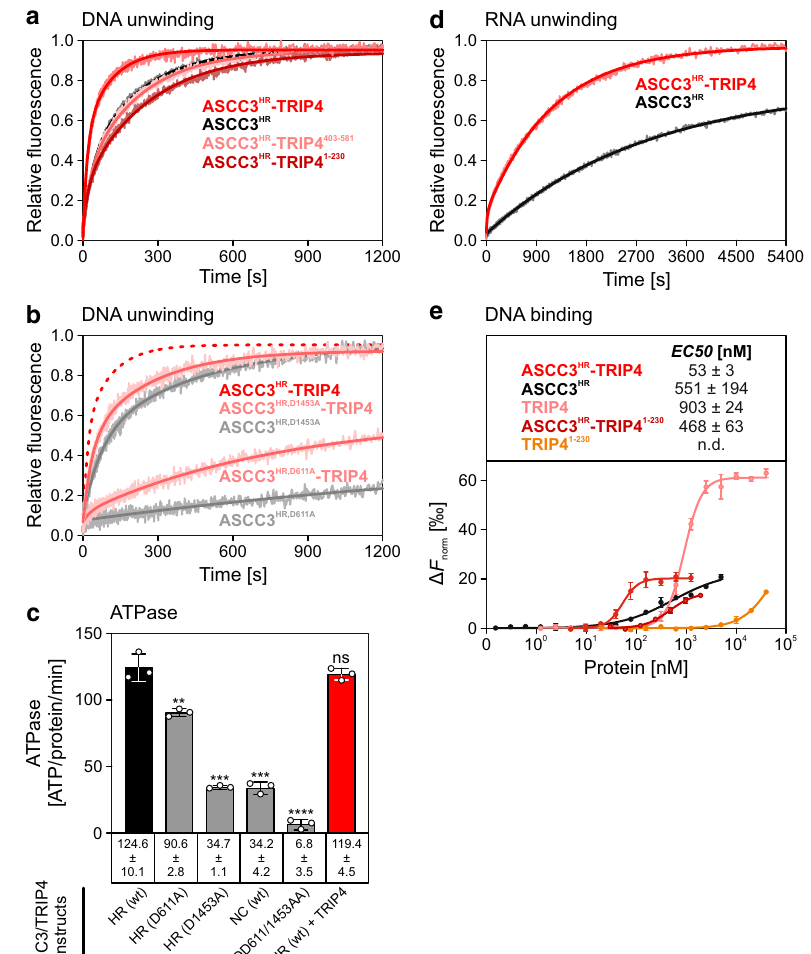
Fig. 3 | ModulationofASCC3 HR helicase, ATPase, and DNA binding activitiesby areshown.ApparentATPaserateswerecalculatedasdescribedin “ Methods ” andin TRIP4. a Stopped- fl ow/ fl uorescence-based DNA unwinding assays (no trap), Supplementary Fig. 7. Statistical signi fi cance was determined by unpaired, two- sided t tests. Signi fi cance indicators represent the signi fi cance of differences to wt showing that TRIP4, but not TRIP4 1 – 230 or TRIP4 403 – 581 , stimulates ASCC3 HR DNA ASCC3 HR ; ** P = 0.0049; *** P = 0.0001; **** P < 0.0001; ns not signi fi cant. ASCC3 HR helicase activity. In this and analogous experiments in the following, curves show fi ts of the data to a double exponential equation (fraction unwound = A – constructs,inwhicheithertheNC(D611A)ortheCC(D1463A)areinactivated,show fast *(1 exp( – k fast * t )) + A slow * (1 – exp( – k slow * t )); A fast/slow , unwinding amplitudes of the reduced ATPase activities, and TRIP4 does not signi fi cantly enhance the ASCC3 HR ATPase. d Stopped- fl ow/ fl uorescence-based RNA unwinding assays (no trap), fast/slow phases; k fast/slow , unwinding rate constants of the fast/slow phases [s − 1 ]; t , time [s]) 35 . b Stopped- fl ow/ fl uorescence-based assays (no trap) monitoring DNA showing that ASCC3 HR can unwind RNA duplexes and that ASCC3 HR -based RNA unwinding by ASCC3 HR constructs, in which either the NC (D611A) or the CC unwinding is also modulated by TRIP4. e MST assays monitoring DNA binding by (D1463A) are inactivated, alone or in the presence of TRIP4, showing that both NC the indicated ASCC3 and TRIP4 variantsor complexes. Data represent means±SD; and CC exhibit helicase activities that are stimulated by TRIP4. Data for n =3 (ASCC3 HR ), n=7 (ASCC3 HR -TRIP4), n =6 (ASCC3 HR -TRIP4 1 – 230 ), n =4 (TRIP4) or ASCC3 HR,D611A -based DNA unwinding had been reported previously 10 and are n =6 (TRIP4 1 – 230 ) technical replicates. Curves show fi ts of the data to a Hill model reproduced here to facilitate direct comparison. c Apparent DNA-stimulated ( F norm = F norm,max * X h / ( EC50 h + X h ); F norm,max , maximum F norm value; X , concentra- tionoftheproteinorproteincomplex; h ,Hillslope; EC50 ,concentrationneededto ATPaseratesofASCC3constructsaloneorincomplexwithTRIP4(indicated atthe achieve a half-maximum binding at equilibrium). Source data are provided as a bottom). HR, helicase region; NC, N-terminal cassette. Values represent means Source Data fi (bars)± SD(lines);individualdatapoints(opencircles)for n =3technicalreplicates